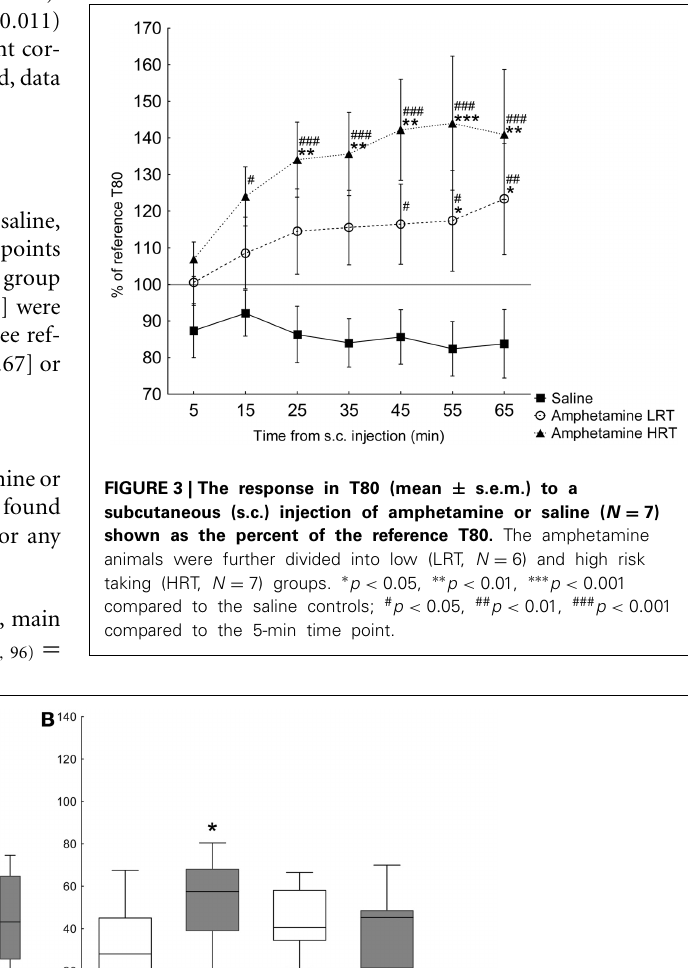
effect of time and group was found [ F (12 , 96) = 2 . 2; p = 0 . 02], Figure 3 . T80 in the HRT animals increased 15 min after the amphetamine injection while in the LRT animals a signifi- cant increase was not seen until 45 min after the injection, Figure 3 . Similarly, the HRT animals were significantly differ- ent from the saline controls at 25 min after injection, whereas the LRT animals were not significantly different from con- trols until 55 min after injection, Figure 3 . However, there was no significant difference in response between the LRT and HRT animals. The saline controls did not change over time, Figure 3 .